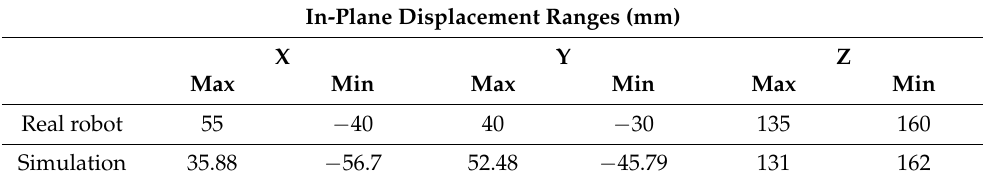
Table 3. Comparison of the displacement ranges between the second segment of the flexible robot and the simulation. Source: authors.